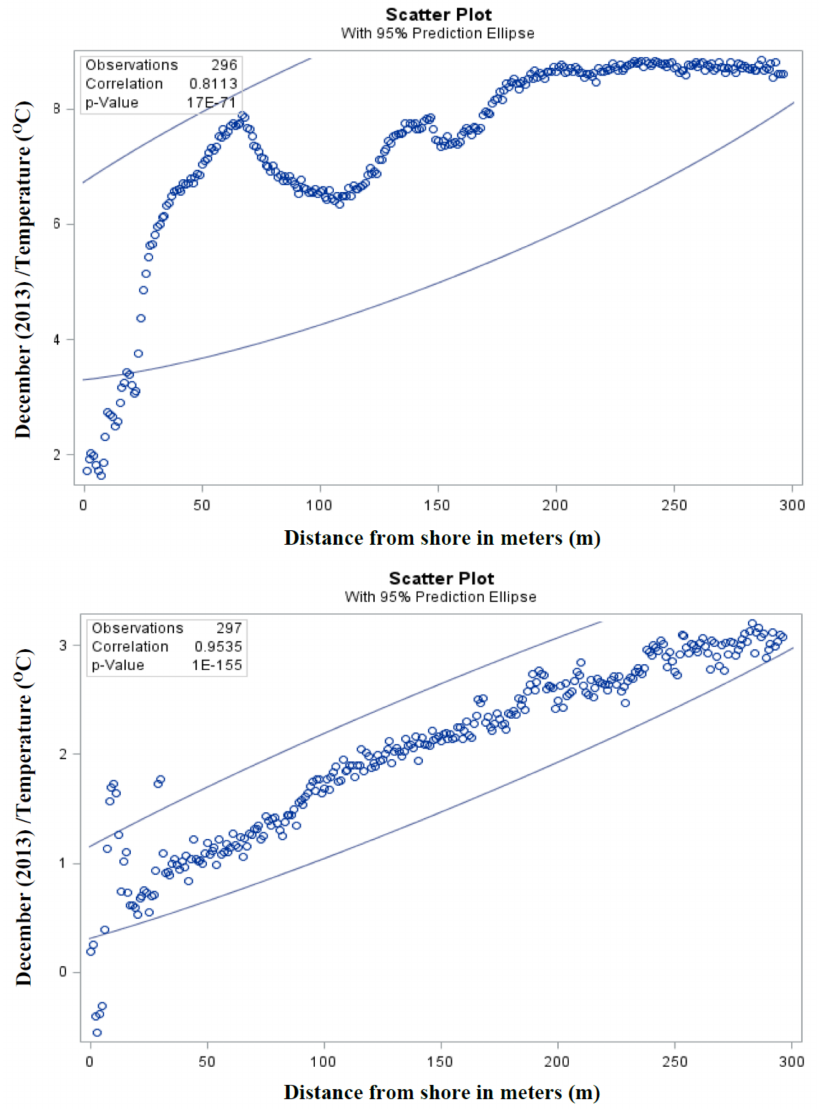
Figure 9. Plot showing Pearson’s correlation between December 2013 temperature and distance at the city of Vaasa, Suvilahti. Ketunkatu (above) and Liito-oravankatu (below). The meaning of p -value = 17E − 71 = 17 × 10 − 71 ( above ). The meaning of p -value = 1E − 155 = 1 × 10 − 155 ( below ). November 2013 and October 2013 show statistically significant positive correlations. This is because both months’ temperatures were very similar; however, the variation in correlation values between the two sites reflects the differences in the site installation depth. There is a positive Pearson’s correlation between December 2013 vs. September, October, and November 2013, which is statistically significant. This is because these months have similar air temperatures and cause similar sediment heat temperatures. However, the correlations between December 2013 and August 2013 show a statistically significant negative correlation. This can be explained by the difference between the two months’ air temperature levels causing different sediment heat temperatures. Figure 10 shows the scatter plot matrix for all the correlation figures presented between the months of the year in 2013 and distance for both